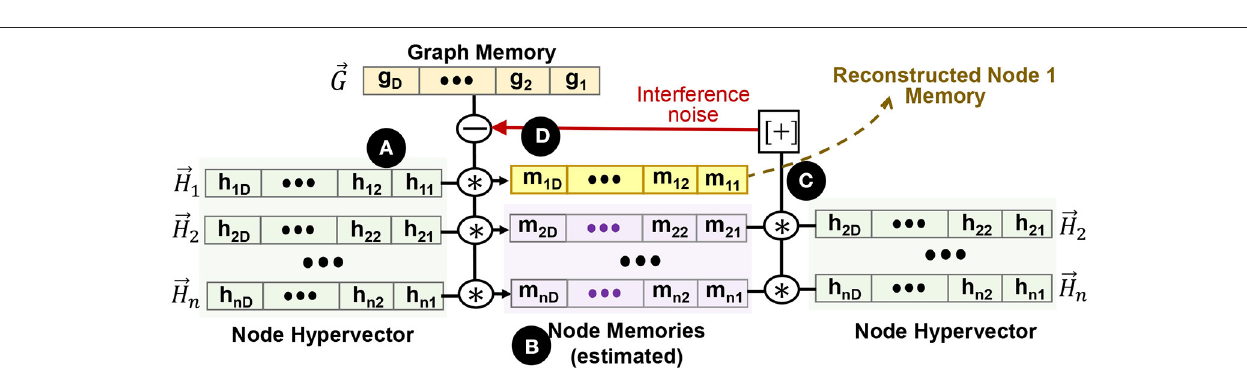
FIGURE 4 | Information retrieval (A) Distribution of signal and noise during information retrieval, and (B) ROC curves for different dimensionalities.